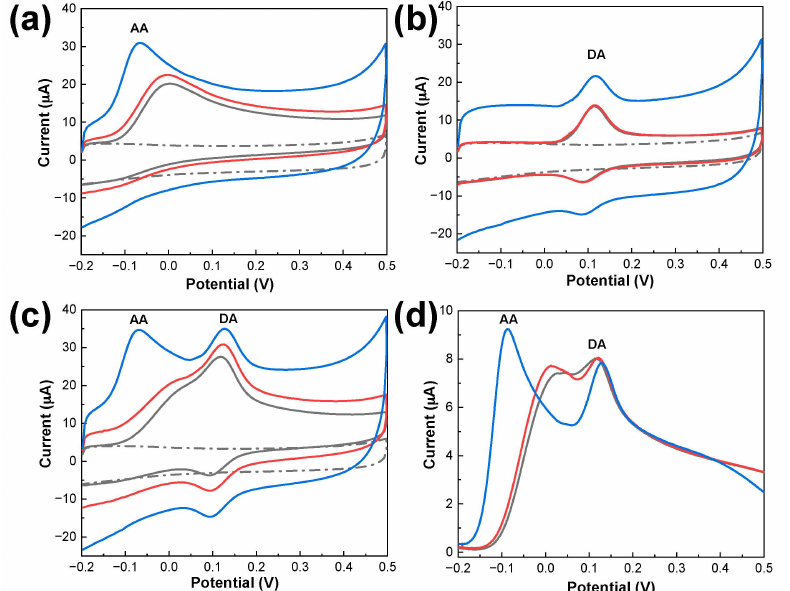
Figure 3. CV curves measured in ( a ) 500 µ M AA; ( b ) 50 µ M DA; ( c ) the mixture of 500 µ M AA and 50 µ M DA with bare SPCE (black line), rGO/SPCE (red line), and PD b S–rGO/SPCE (blue line). CV curves for bare SPCE measured in 50 mM PBS (pH 7.0) are represented as black dash–dot lines. Scan rate: 50 mV s − 1 ; ( d ) LSV curves measured in a mixture of 500 µ M AA and 50 µ M DA for bare SPCE (black line), rGO/SPCE (red line), and PD b S–rGO/SPCE (blue line) at a scan rate of 10 mV s − 1